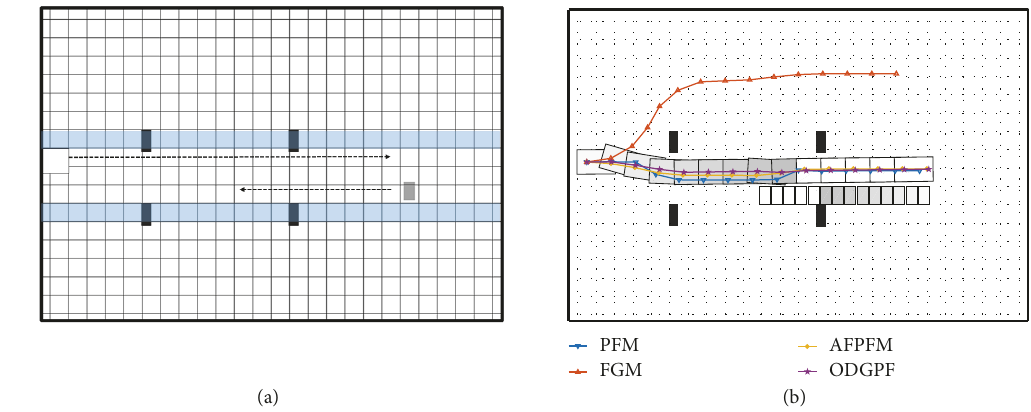
Figure 13: Dynamic environment Scenario 3: (a) scenario and (b) simulation